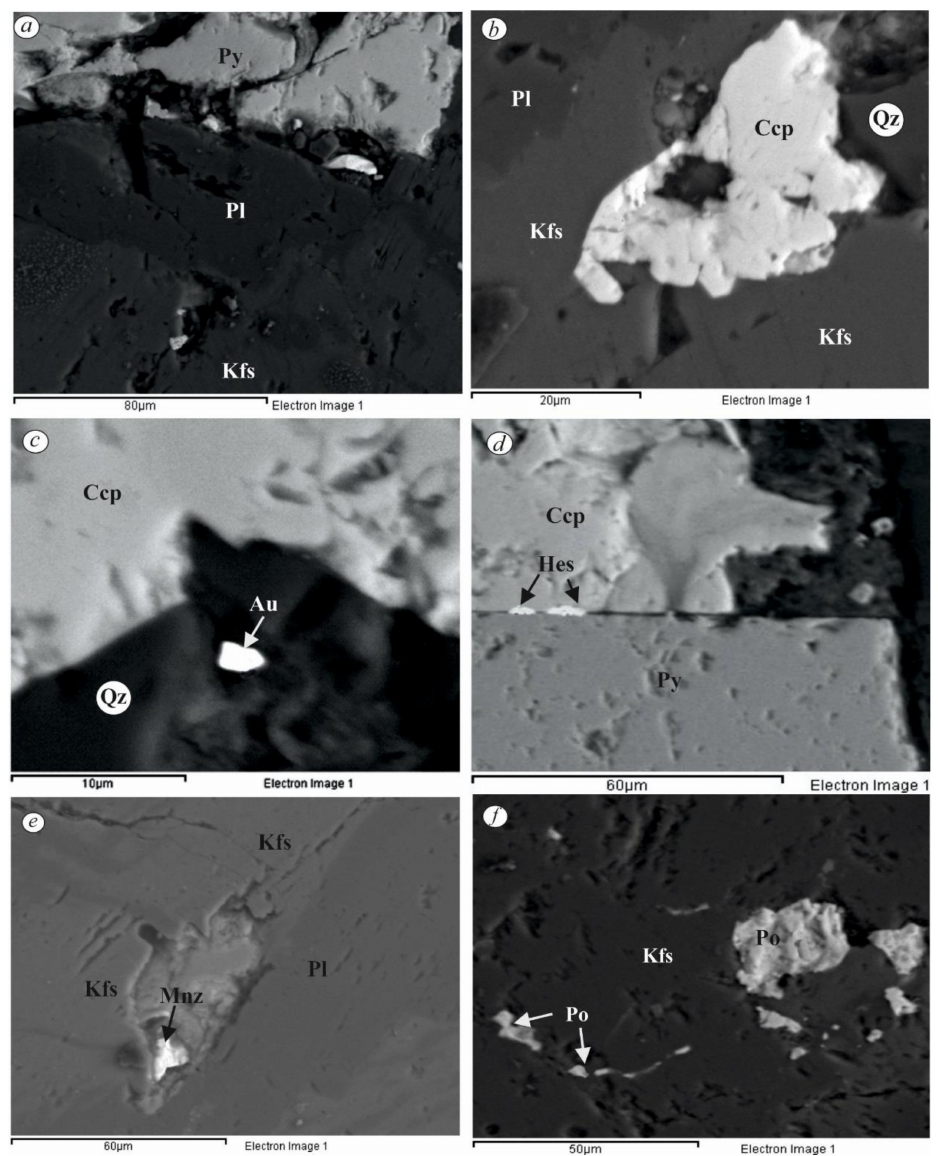
Figure 7. Disseminated ore mineralization in the alkali feldspar syenites: ( a ) pyrite (Py) in a plagioclase (Pl)–K-feldspar (Kfs) substratum; ( b ) a chalcopyrite (Ccp) grain; ( c ) a small native gold (Au) grain with quartz (Qz) and chalcopyrite (Ccp); ( d ) a hessite (Hes) streak within chalcopyrite (Ccp) and pyrite (Py) intergrowth; ( e ) a monazite (Mnz) grain; ( f ) pyrrhotite (Po) grains in a K-feldspar (Kfs) substratum. Images have been taken in BSE mode. Conventional symbols of minerals have been taken from